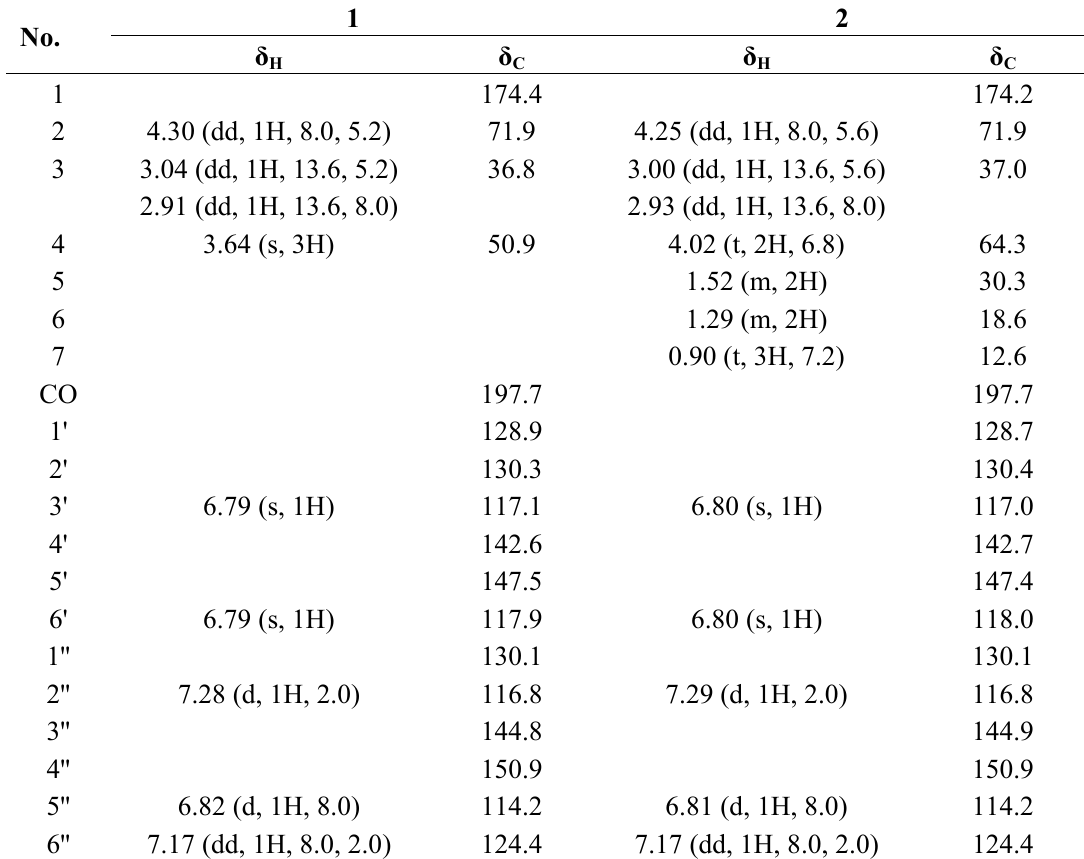
OD, δ ppm, J Hz). 3